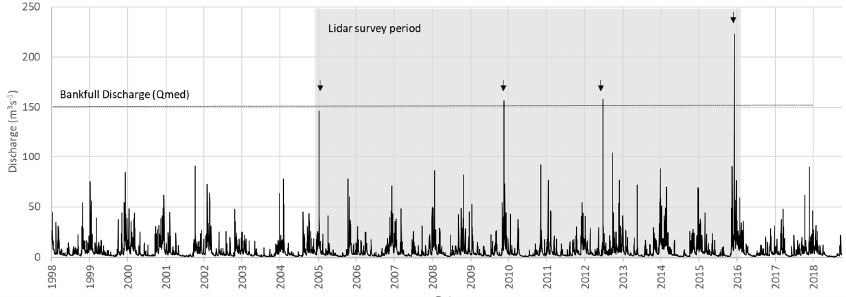
Figure 3. Daily flow data for the River Caldew at Cummersdale, with flows greater than Qmed (the flood with a return period of 2 years) 159 m 3 s − 1 indicated.